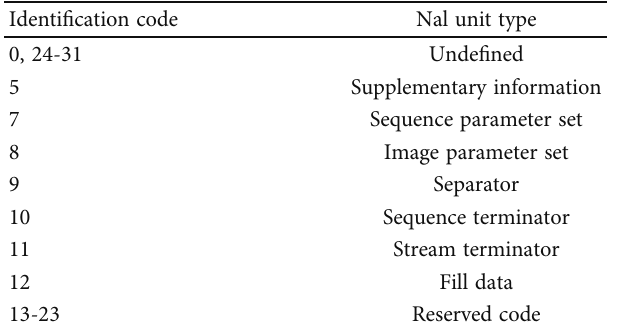
Table 1: Syntax of Nal unit identi fi cation